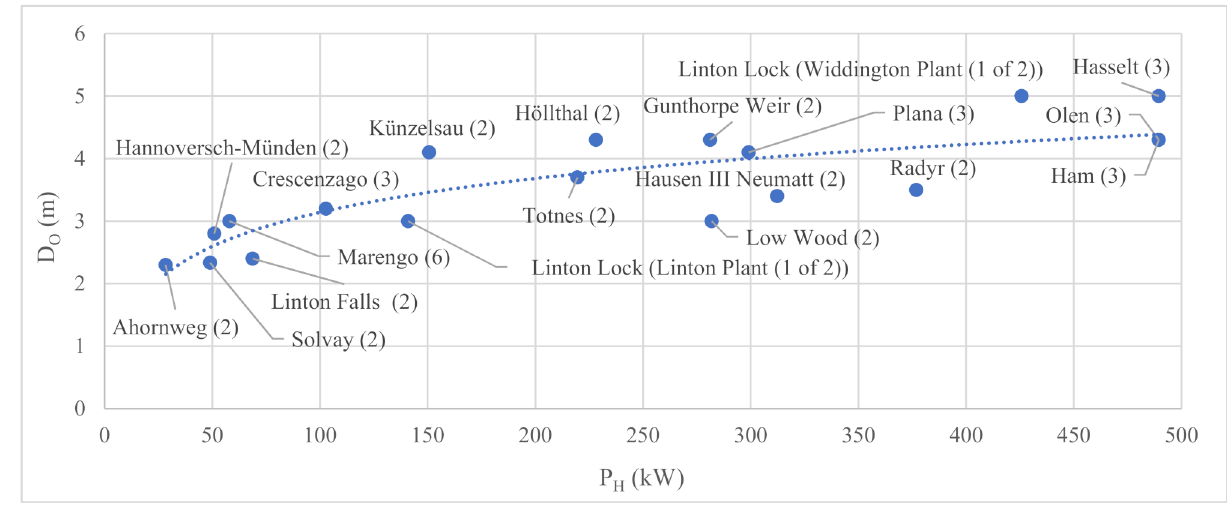
Figure 6. The theoretical available power vs. the diameter and number of installed screws in current hydropower plants represented in Table 2.